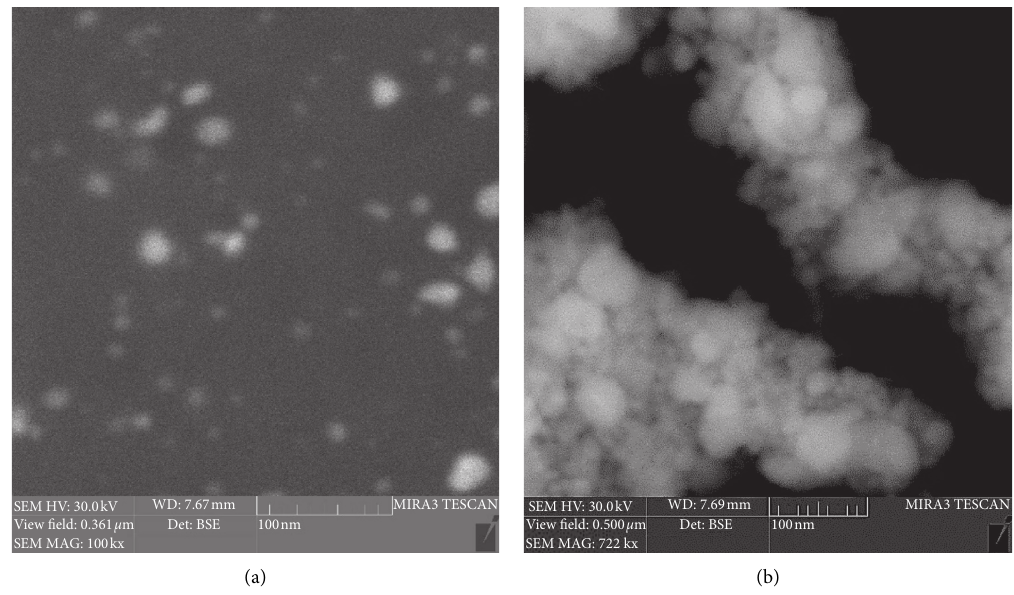
Figure 11: SEM images of silver nanoparticles (C (Ag + ) � 10mmol/L, τ � 30min, and ratio AgNO pomegranate peel (b) extracts (mL) � 1:1).